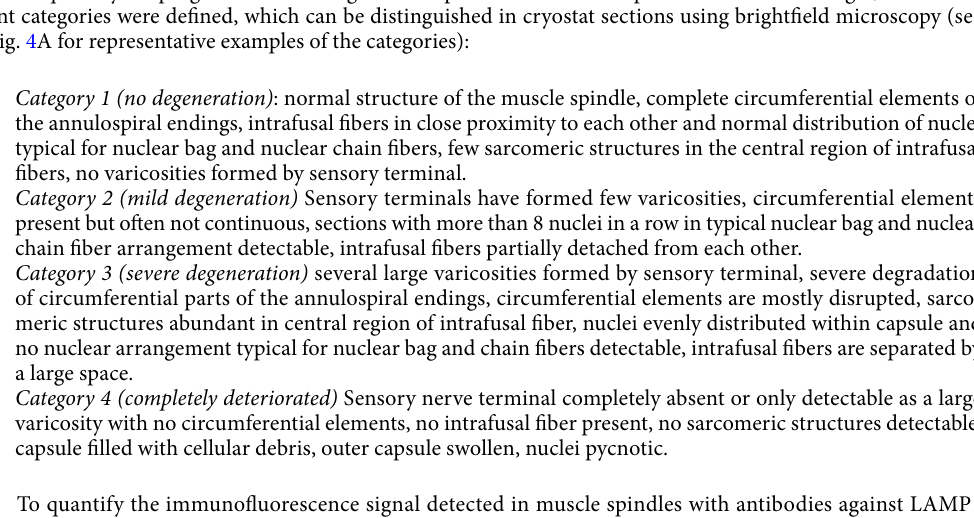
Fig. 4A for representative examples of the categories): Category 1 (no degeneration) : normal structure of the muscle spindle, complete circumferential elements of the annulospiral endings, intrafusal fibers in close proximity to each other and normal distribution of